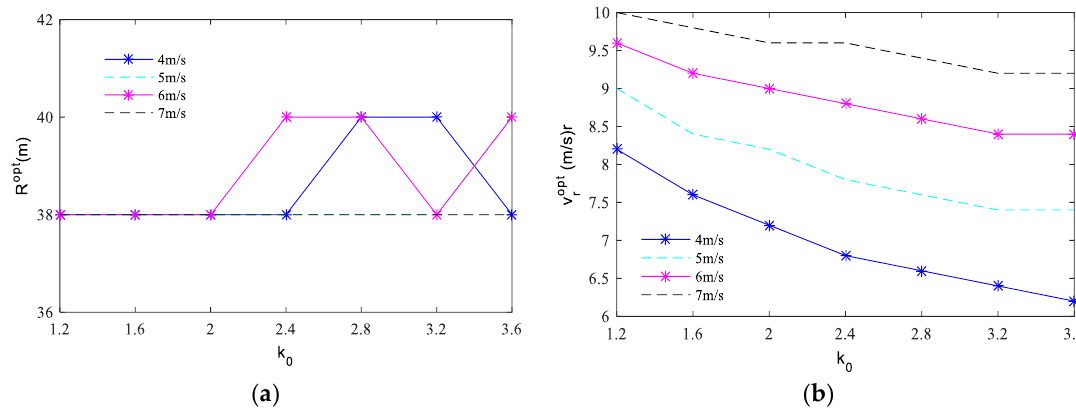
Figure 4. The optimal design parameters of offshore turbines versus the annual mean wind speeds and the shape factors: ( a ) the rated rator radius; ( b ) the rated wind speed.